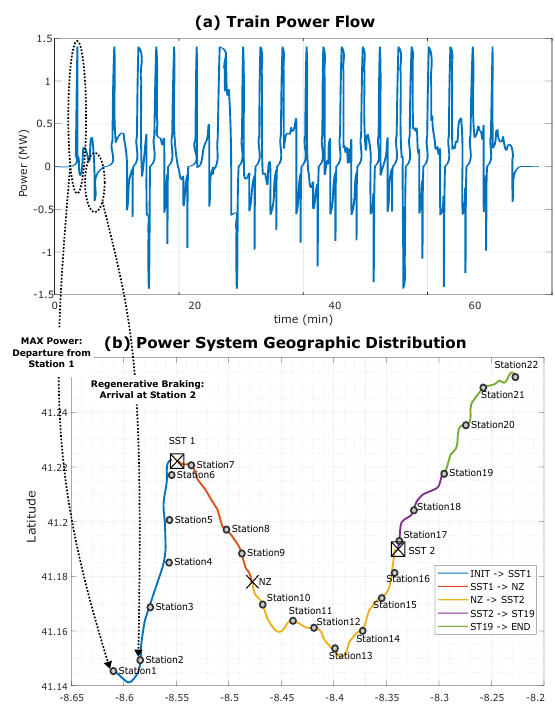
Figure 9. Geographic detail on the train power consumption profile: (a) Power consumption for one journey; (b) Geographic distribution of all 22 passenger stations. Note: the 21 spikes in the train power flow corresponds to each departure from stations 1 to 21, as illustrated; The first station is Porto São-Bento and the last one is Caíde station, in the portuguese Douro line.